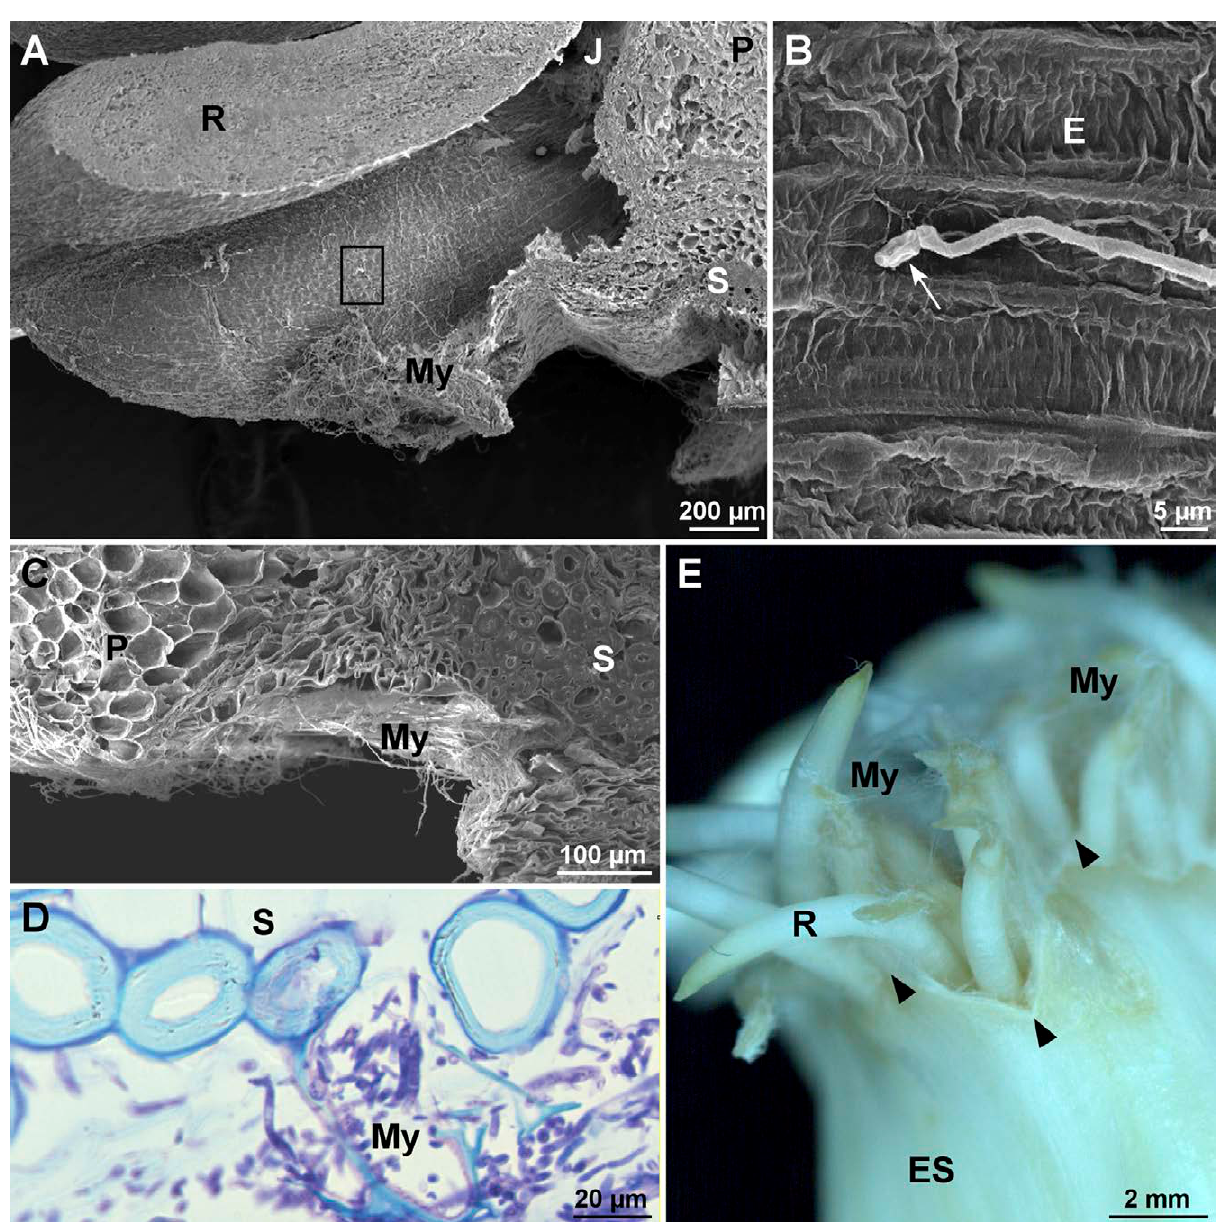
Figure 2. Mycelium development of Fusarium proliferatum. A, SEM micrograph of a germinating garlic root. B, High magnification of the area indicated by the square in A. C, Section of the basal part of an infected clove. D, Detail of suberized tissue. E, Basal part of a clove 72 h post inoculation. R: roots, J: junction, P: parenchyma, My: mycelium, E: epidermis, S: thick-walled cells, ES: external scale. White arrow in B indicates a germinated conidium. Black arrowheads in E indicate junctions between roots and between the abscission zone boundary and root primordia. A and B, Scanning electron micrographs. D, Light micrograph after TB staining. E,